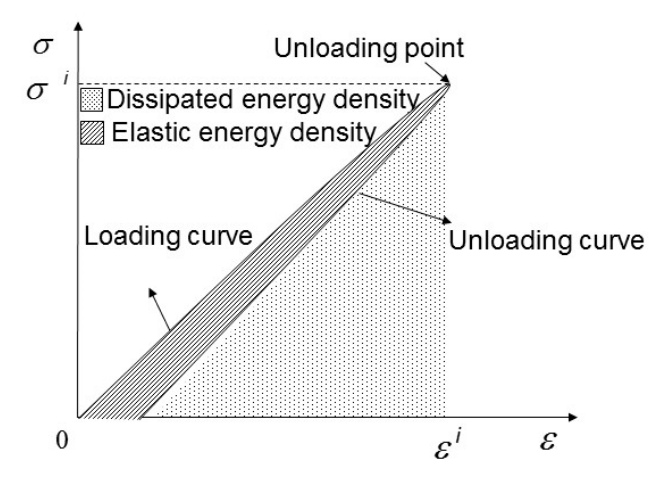
Figure 1. Calculation of dissipative energy and elastic energy in a cycle.